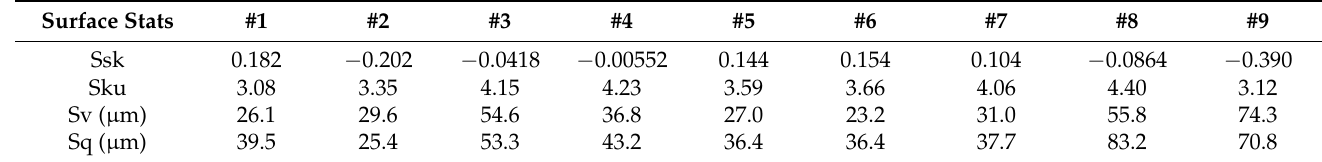
Table 3. Coating surface stats parameters.